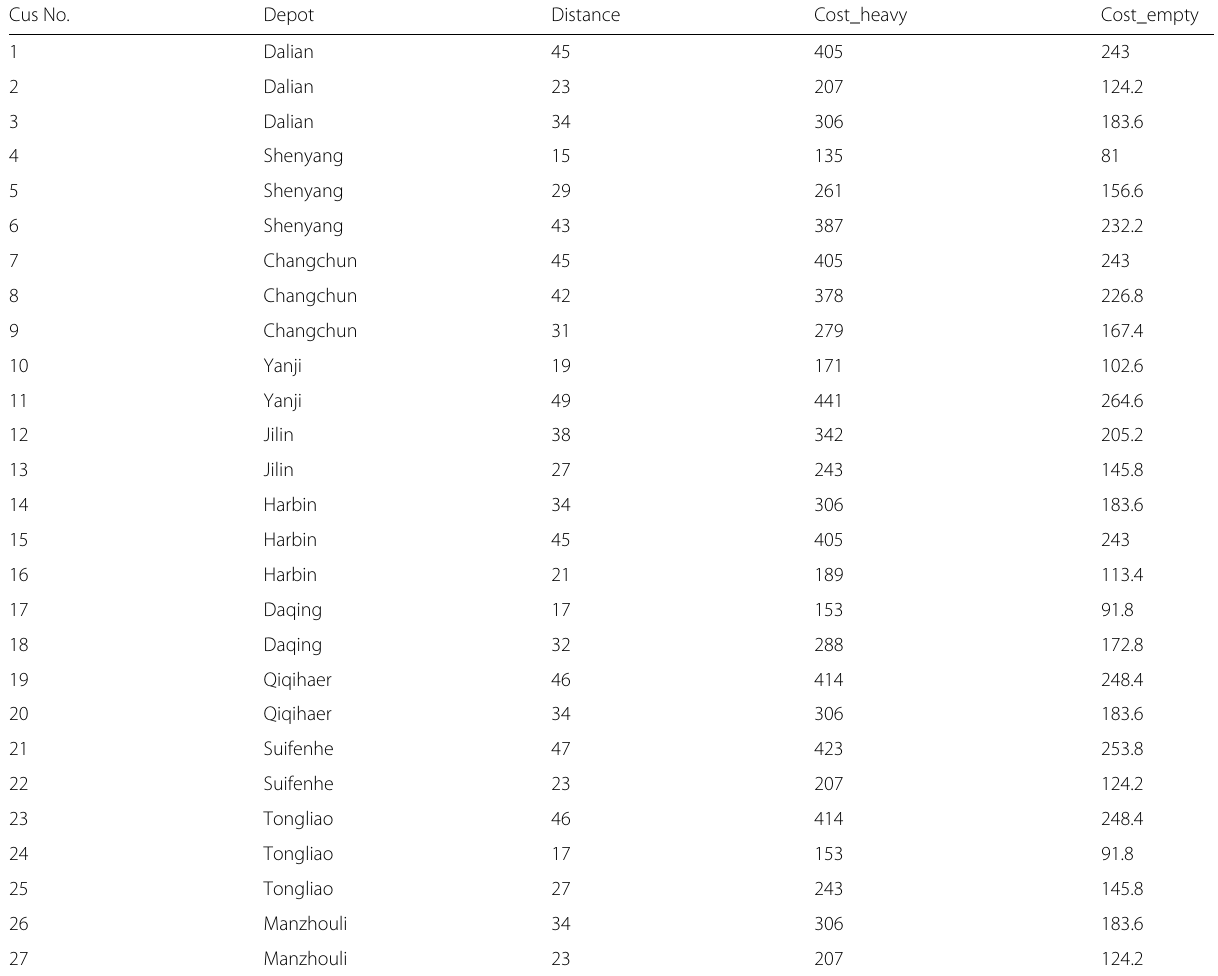
Table 7 Distance between customers and container depots (km), Unit transport cost of a heavy container between customers and depots (CNY), Unit cost of an empty container between customers and depots (CNY) Cus